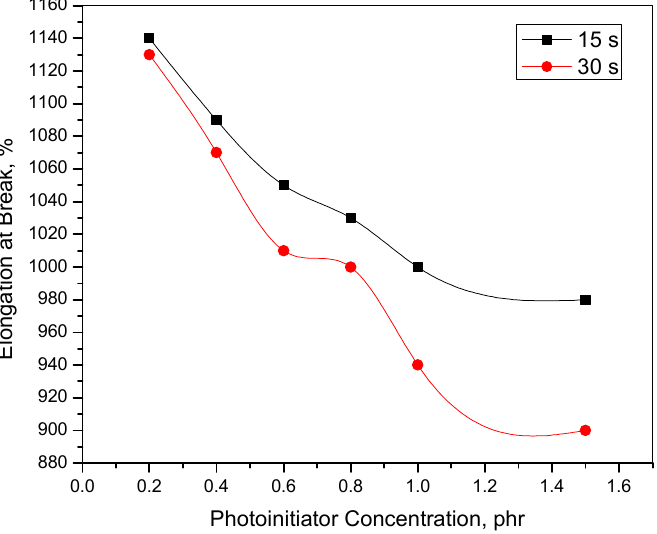
Figure 4. Elongation at break as a function of photoinitiator concentration. However, in the present study, it was observed that the crosslink density continuously increased as a function of the photoinitiator concentration, though at a little lesser rate from 1.0 to 1.5, as is shown in Figure 6, but the modulus at any of the three defined elongations decreased from 1.0 to 1.5 phr of the photoinitiator